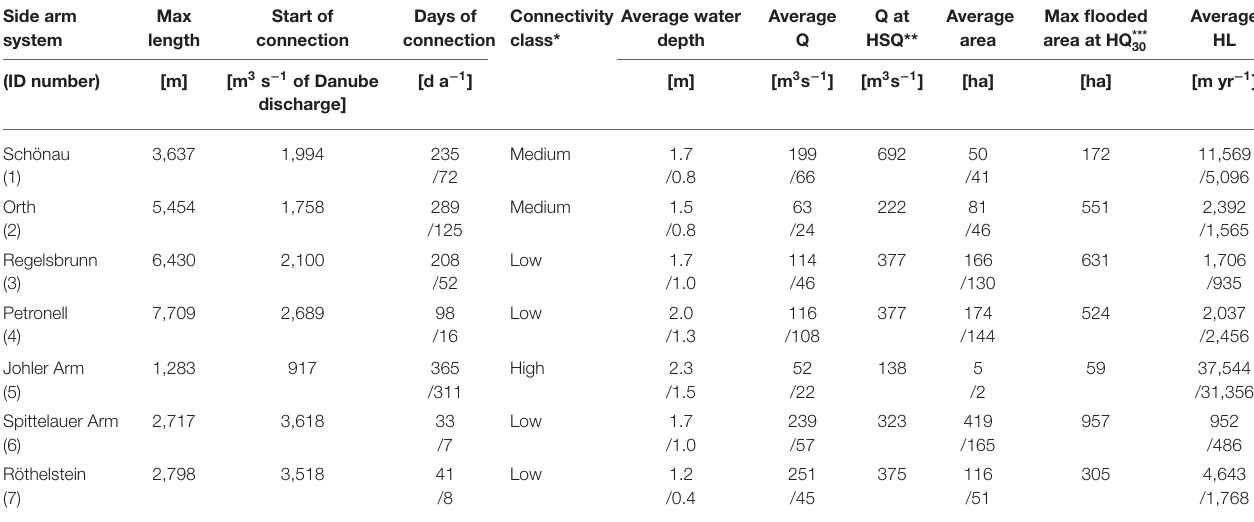
TABLE 1 | Summary of connectivity-related hydro-morphological characteristics of the side arms in the current state for wet/dry years. Side arm